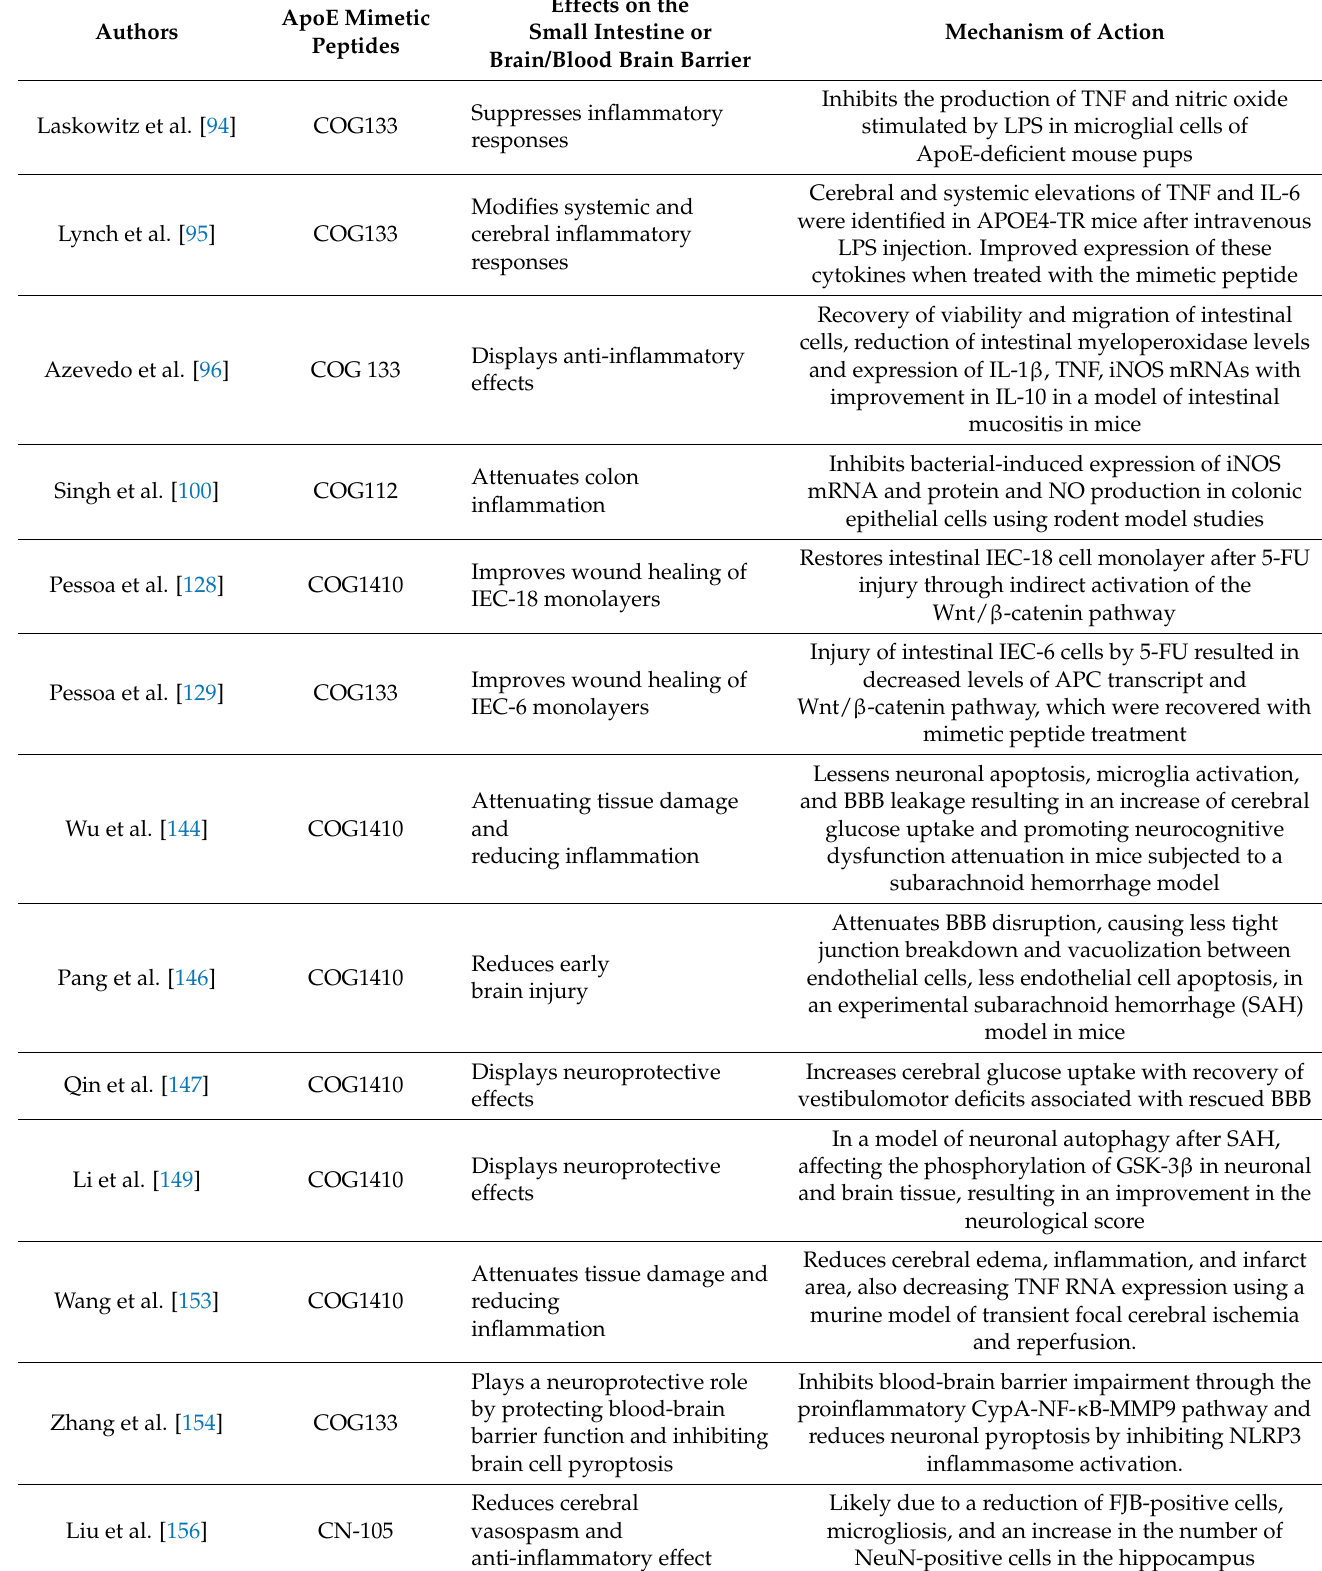
Table 1. Summary of apoE mimetic peptide research findings in inflammatory gut and brain